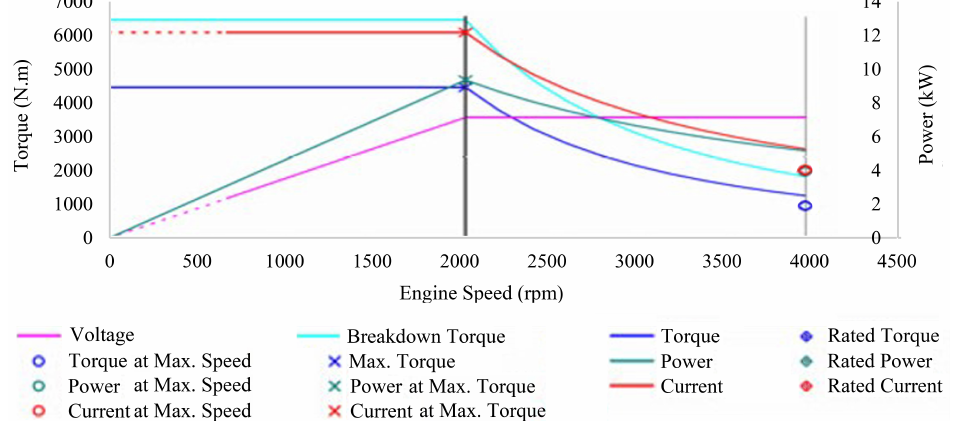
Figure 4. Specifications of the EV given by the manufacturer.